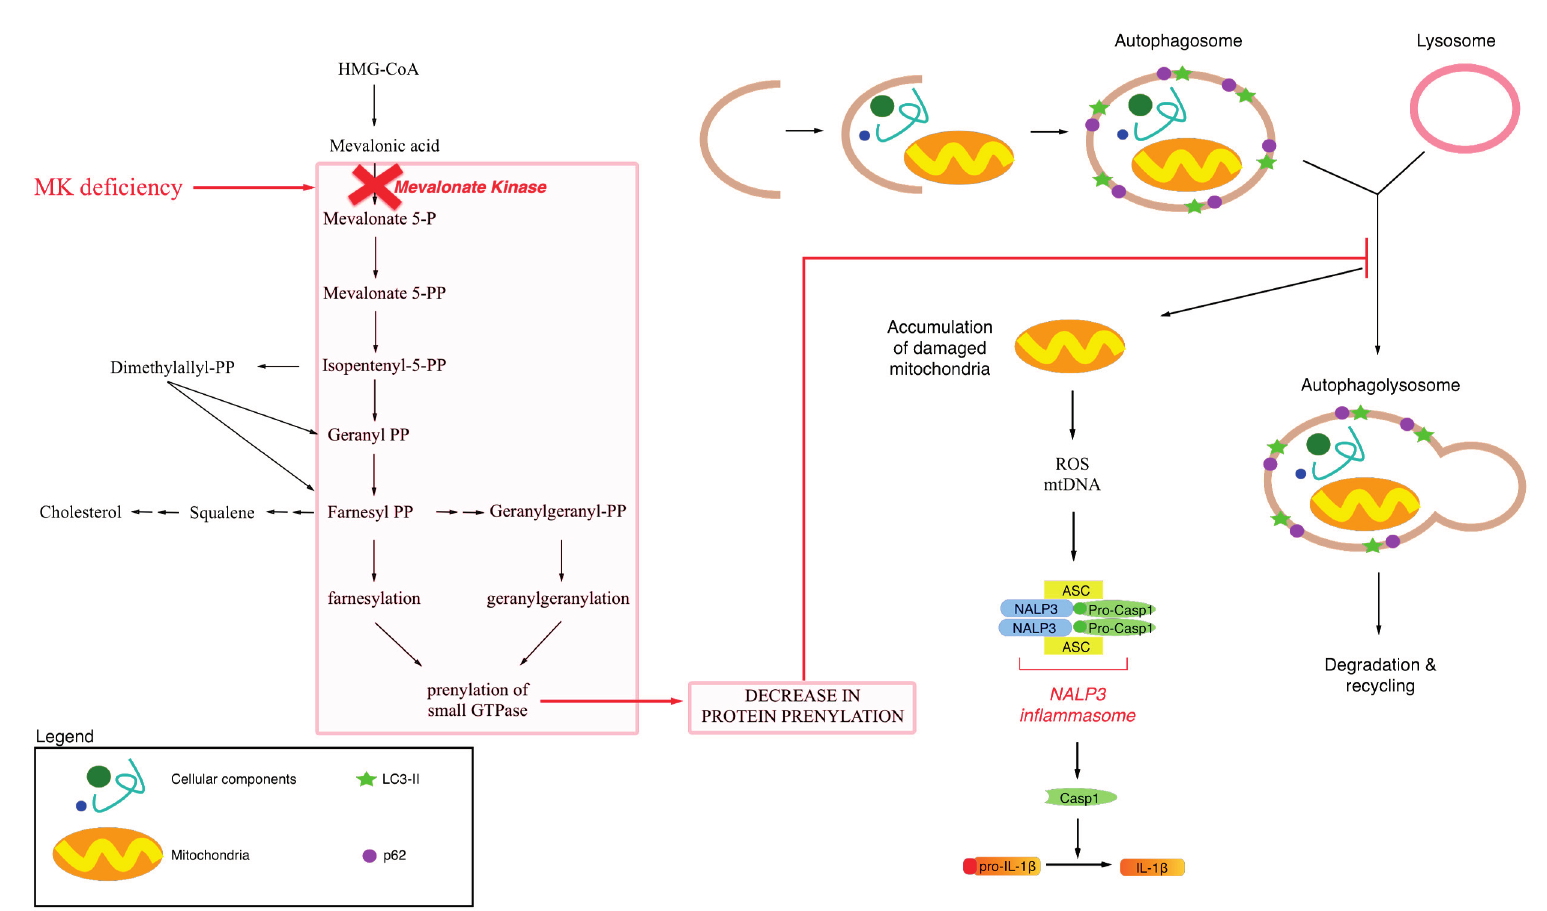
Figure 3. Schematic representation of a possibile link between defective protein prenylation, mitochondrial dysfunction and autophagy. Mevalonate Kinase Deficiency is characterized by a block of the mevalonate pathway induces by mutation in a gene that encodes for Mevalonate Kinase. Blockade of the mevalonate pathway induces decrease in protein prenylation that could alter the macroautophagy mechanism and in particular mitochondrial degradation and recycling. Accumulation of damaged mitochondria induces ROS production and mtDNA release. All these events are important for the activation of NALP3 inflammasome that cleaves and activates